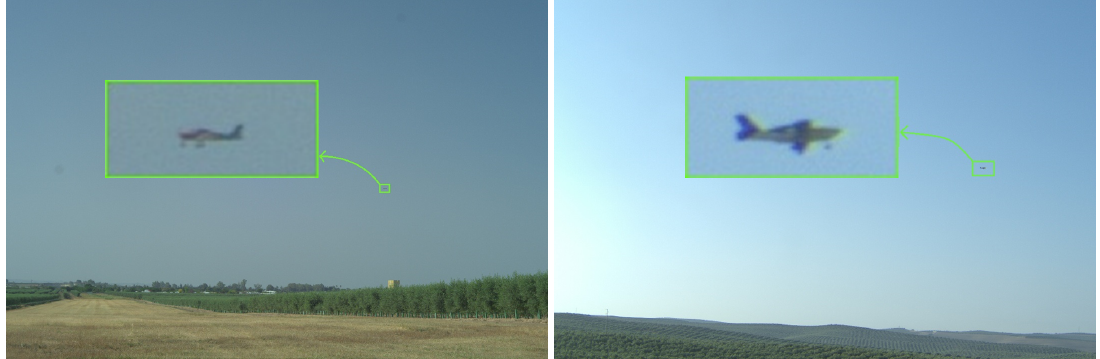
Figure 1. Images captured from the ground-based system, showing a small aircraft (SOCATA TB9) flying at a distance of two kilometers. Image resolution: 5472 × 3648 (20 MP); angle of view: 32.9 ◦ (horizontal) and 24.8 ◦ (vertical). Long-range detection poses a challenge to both image and audio-based